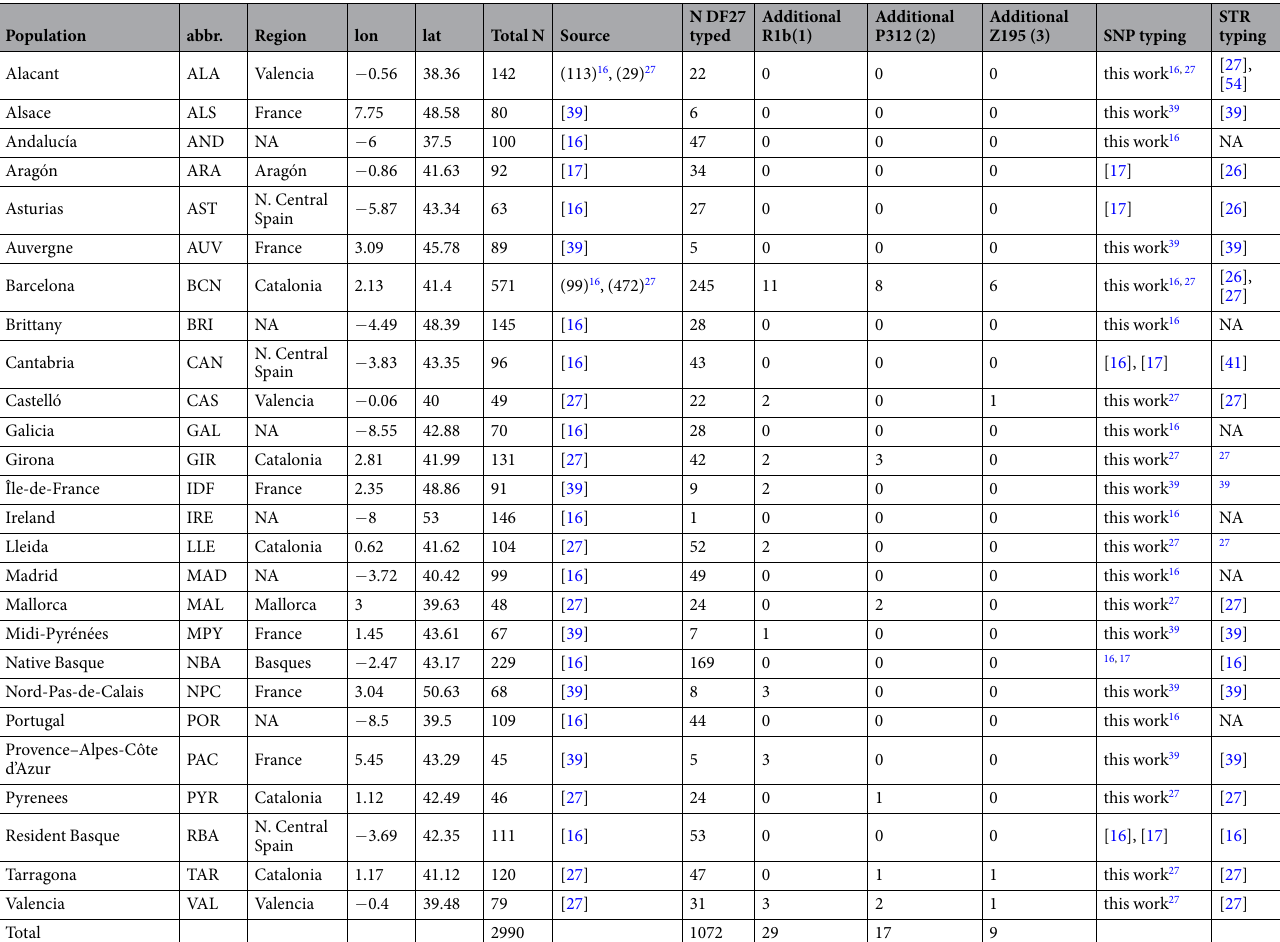
Table 1. Populations sampled and their original sources. Region: higher population grouping used in some analyses. (1): Chromosomes predicted to be R1b but without further SNP typing; (2): Chromosomes